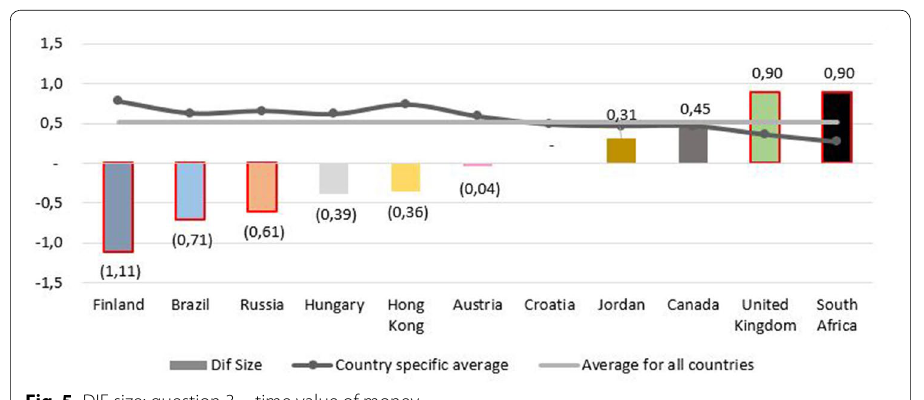
Fig. 5 DIF size: question 3—time value of